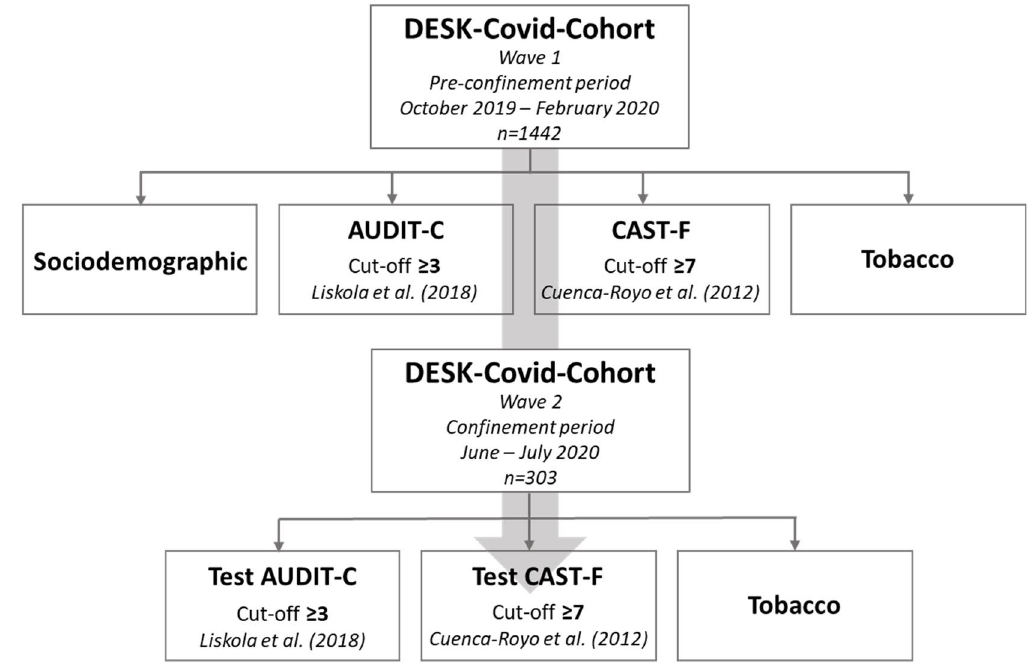
Figure 1. Methodology of DESK-COVID-Cohort in the two waves of the study and tests used to assess substance use.